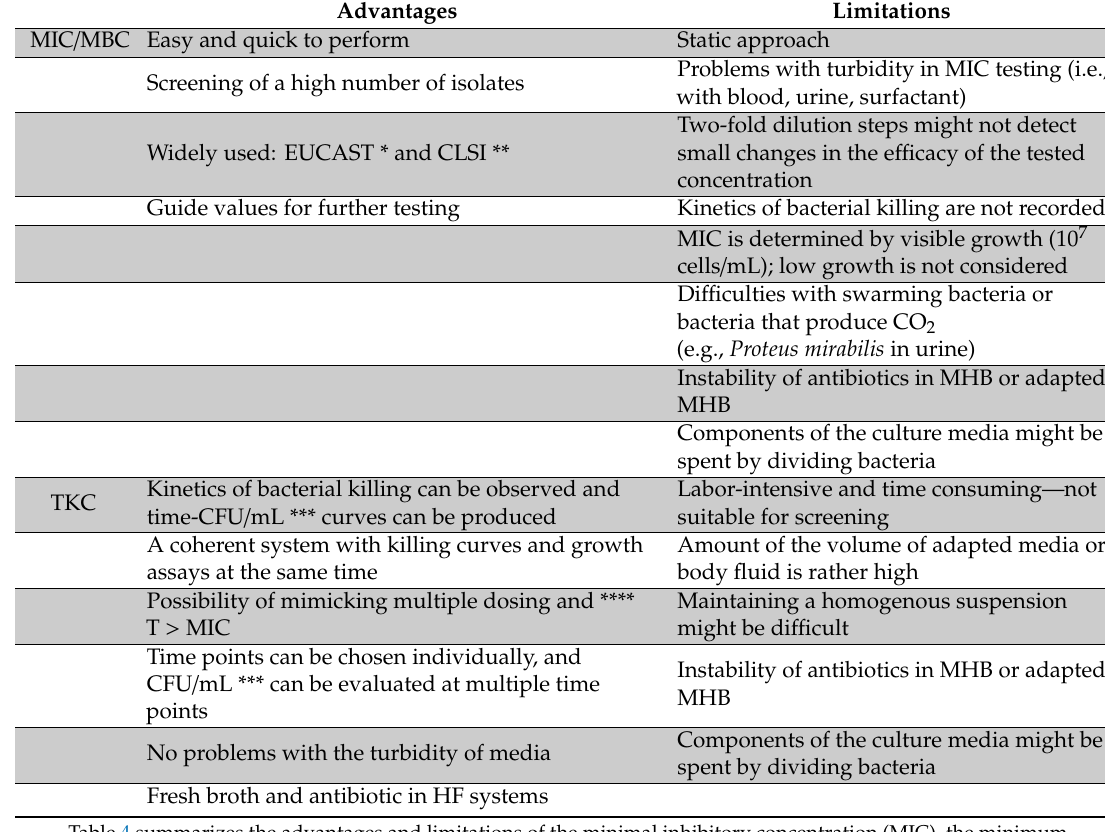
Table 4. Pros and cons for MIC and TKCs, with adapted media and body fluids as media.